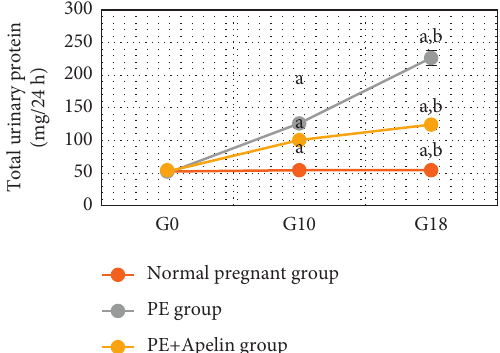
Figure 2: Urine proteins in the studied groups.